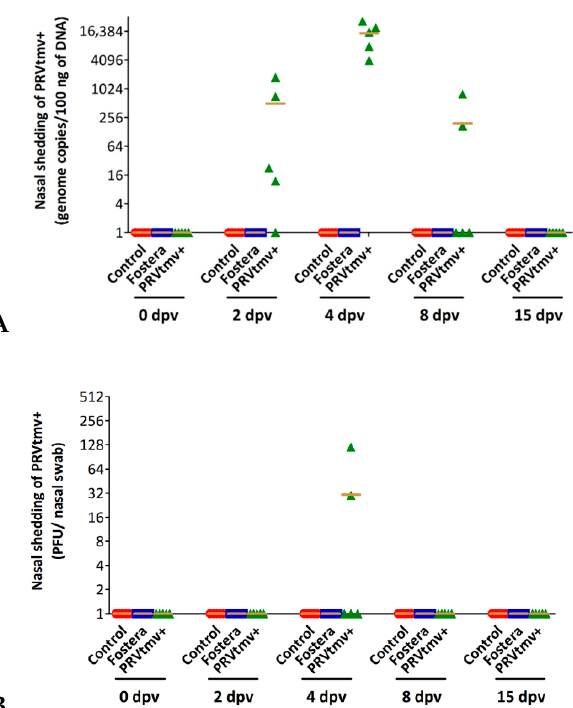
Figure 9. Nasal shedding of PRVtmv+ in immunized pigs assessed by qPCR and virus isolation. ( A ) DNA was isolated from nasal swab following immunization with PRVtmv+ vaccine, and PRV- qPCR was performed. PRV genome copy numbers were calculated according to the CT values of a standard curve. Shown are the mean copy numbers of PRV genome in 100 ng of DNA of two independent qPCR analyses of each animal from three vaccination groups on 0, 2, 4, 8, and 15 dpv. The dot plot graph represents mean + individual values in each group ( n = 5). ( B ) Virus isolated from each animal’s nasal swab following the immunization with PRVtmv+ vaccine was titrated in confluent SK cells by plaque assay. Shown are the virus titers (in plaque-forming unit/mL of the nasal swab; PFU/mL) of each animal from three vaccination groups on 0, 2, 4, 8, and 15 dpv. The dot plot graph represents mean + individual values in each group ( n = 5). dpv—days